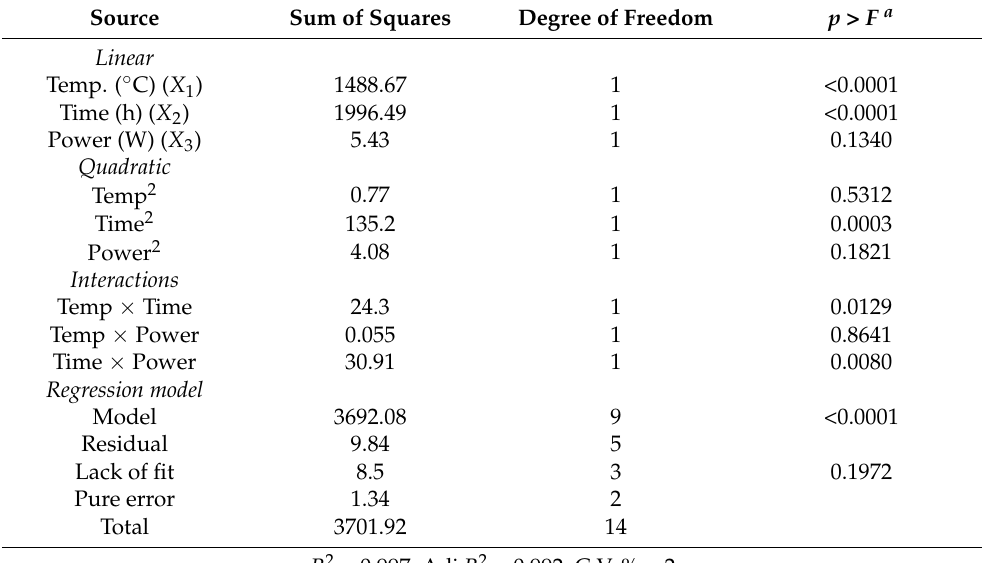
Table 2. Analysis of variance for synthetic variables on response percent molar